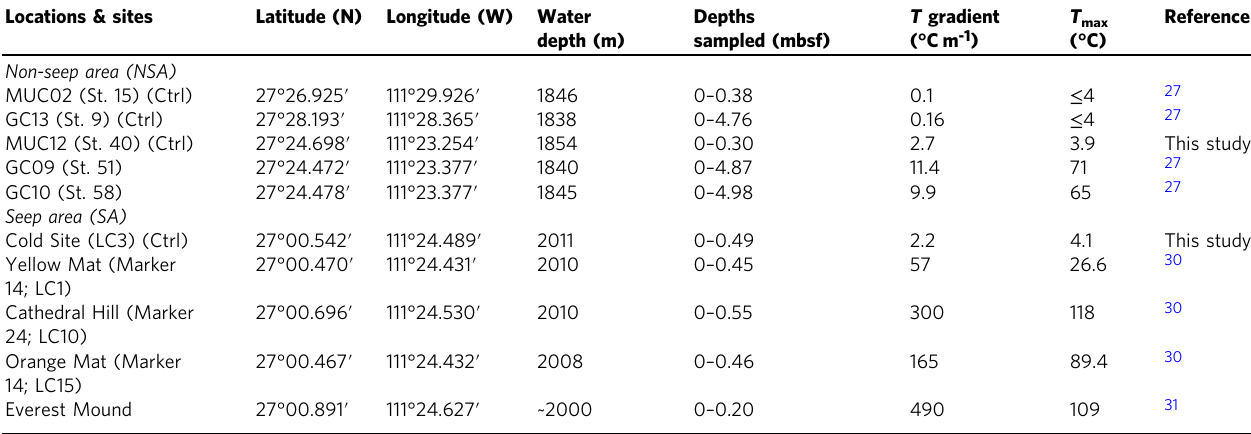
Table 1 Overview of all sampling sites. Locations &